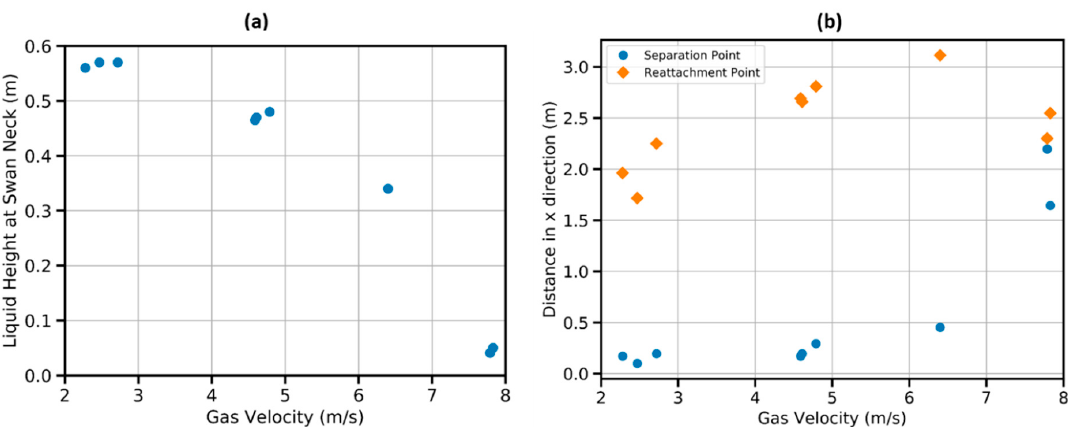
Figure 6. Flow separation at the swan neck. ( a ) Maximum liquid height along the swan neck and ( b ) position of flow separation (blue) and reattachment (orange) against the inlet gas velocity. The results are averaged over a time period of 5s.